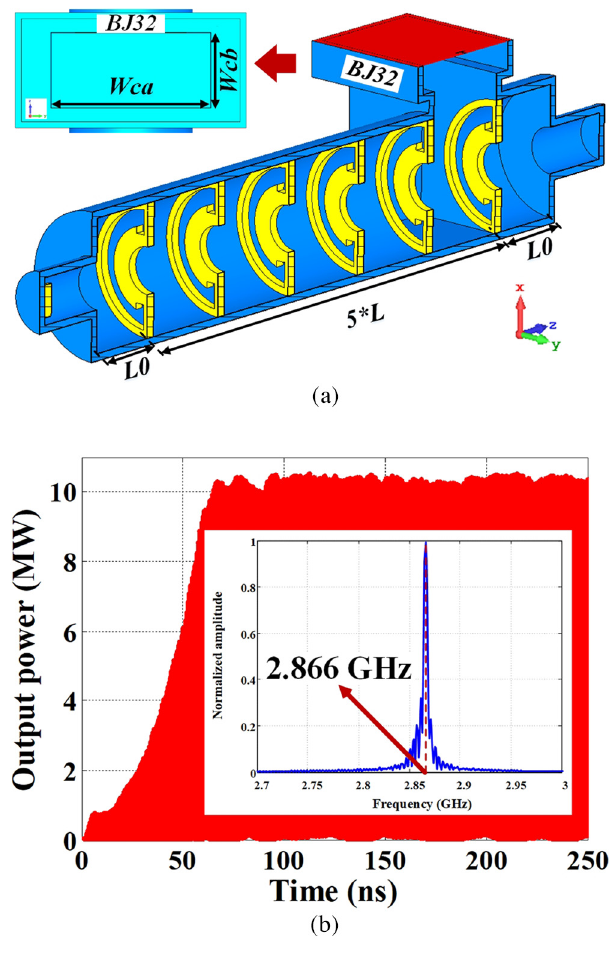
Fig. 7. Simulation model and the PIC beam-wave interaction results in CST. (a) Schematic of the 5-gap MEIO, where the inner diameter is 37mm ( ∼ l /2.83) and the longitudinal interaction length is about 180 mm ( ∼ 1.2 l ), (b) peak output power, and spectrum (inset) of the output signal